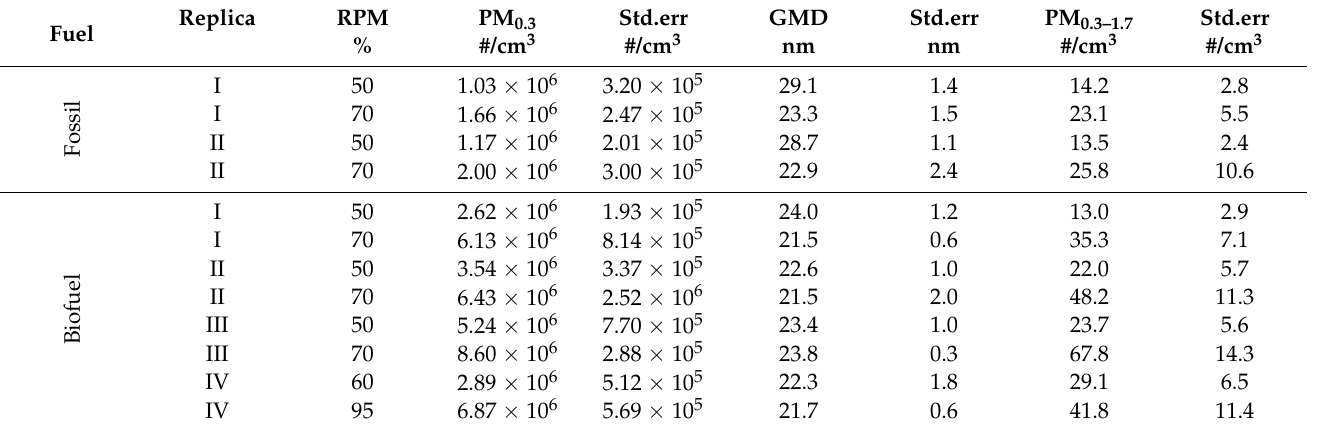
Table 3. Emissions for the fossil fuel and biofuel blends in terms of number of quasi-ultrafine (PM 0.3 ) and fine (PM 0.3–1.7 ) particles and the geometric mean diameter (GMD) after accounting for the dilution factor and background influence.